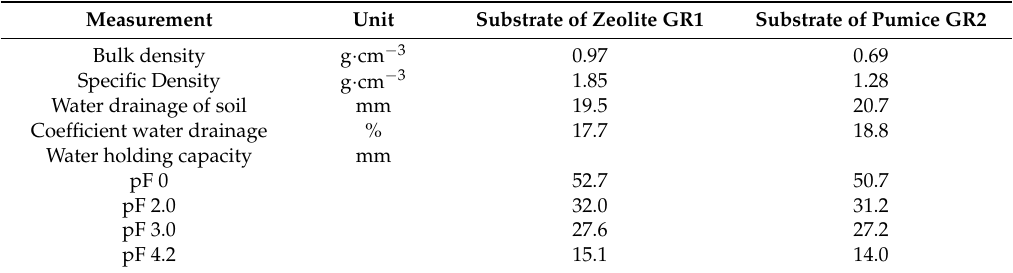
Table 1. Physical properties of the substrate comprised of zeolite and pumice. Values represent the mean values of three